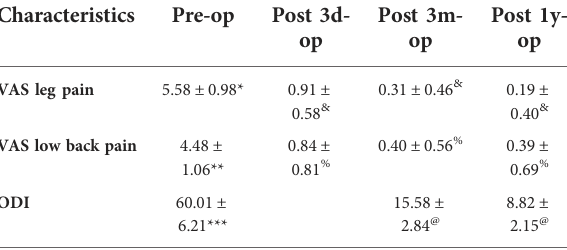
TABLE 2 Comparation of the VAS and ODI between pre and postoperative. Characteristics